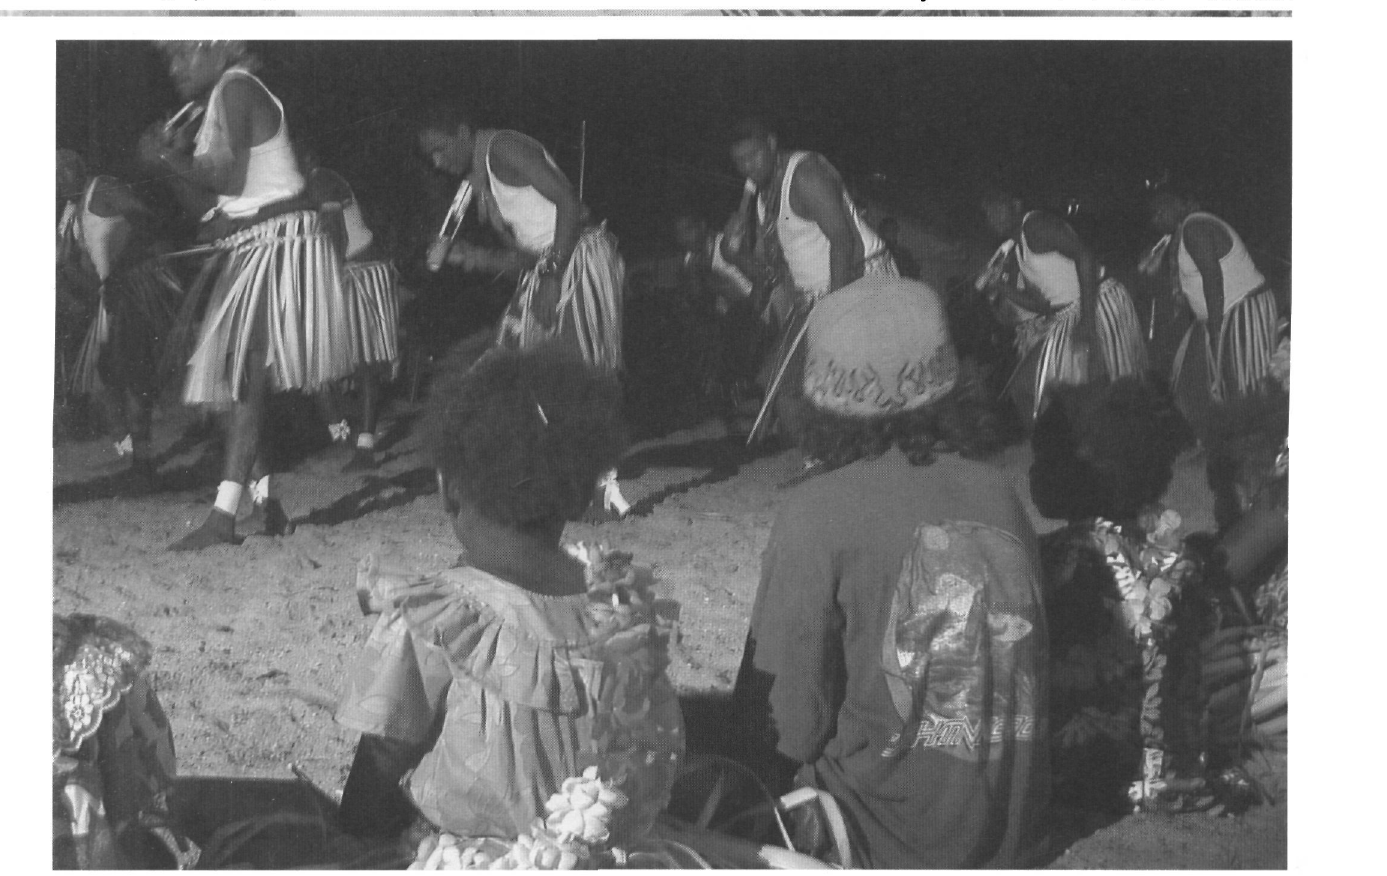
Figure 4. Customary Islander dancing at Zarzar, Kubin, during the Goba celebrations, October